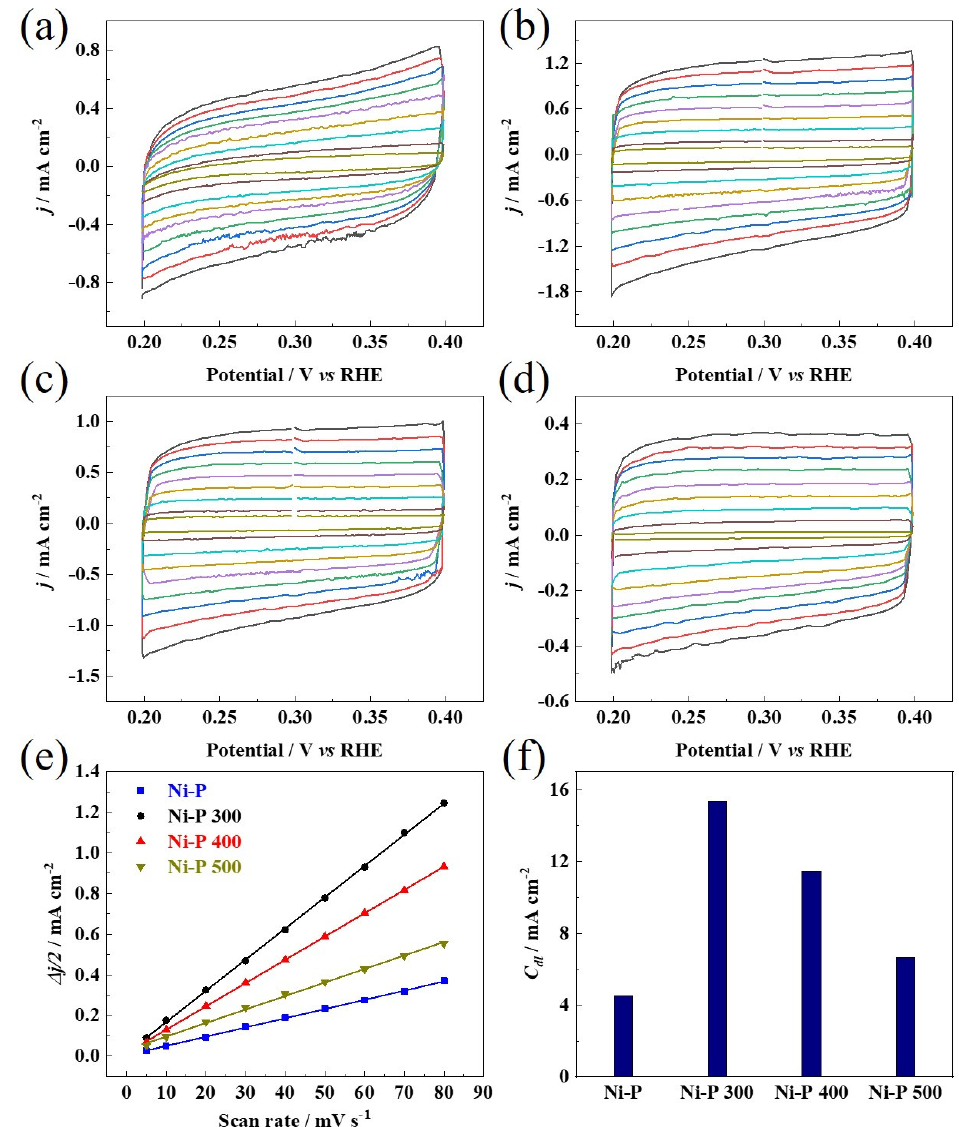
Figure 6. ( a – d ) Electrochemical CV curves of the catalysts recorded in non-Faradaic regions at different scan rates of 5 mV s − 1 , 10 mV s − 1 , 20 mV s − 1 , 30 mV s − 1 , 40 mV s − 1 , 50 mV s − 1 , 60 mV s − 1 , 70 mV s − 1 , 80 mV s − 1 , and corresponding to different color lines from inner to outer. ( e ) Plots of the capacitive currents versus the scan rates. ( f ) C dl value for each catalyst.